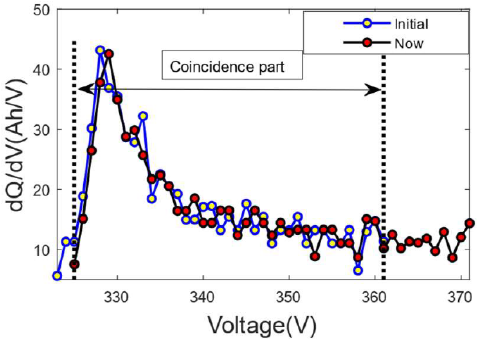
Figure 2. The capacity increment curves of the data segments for battery SOH calibration.